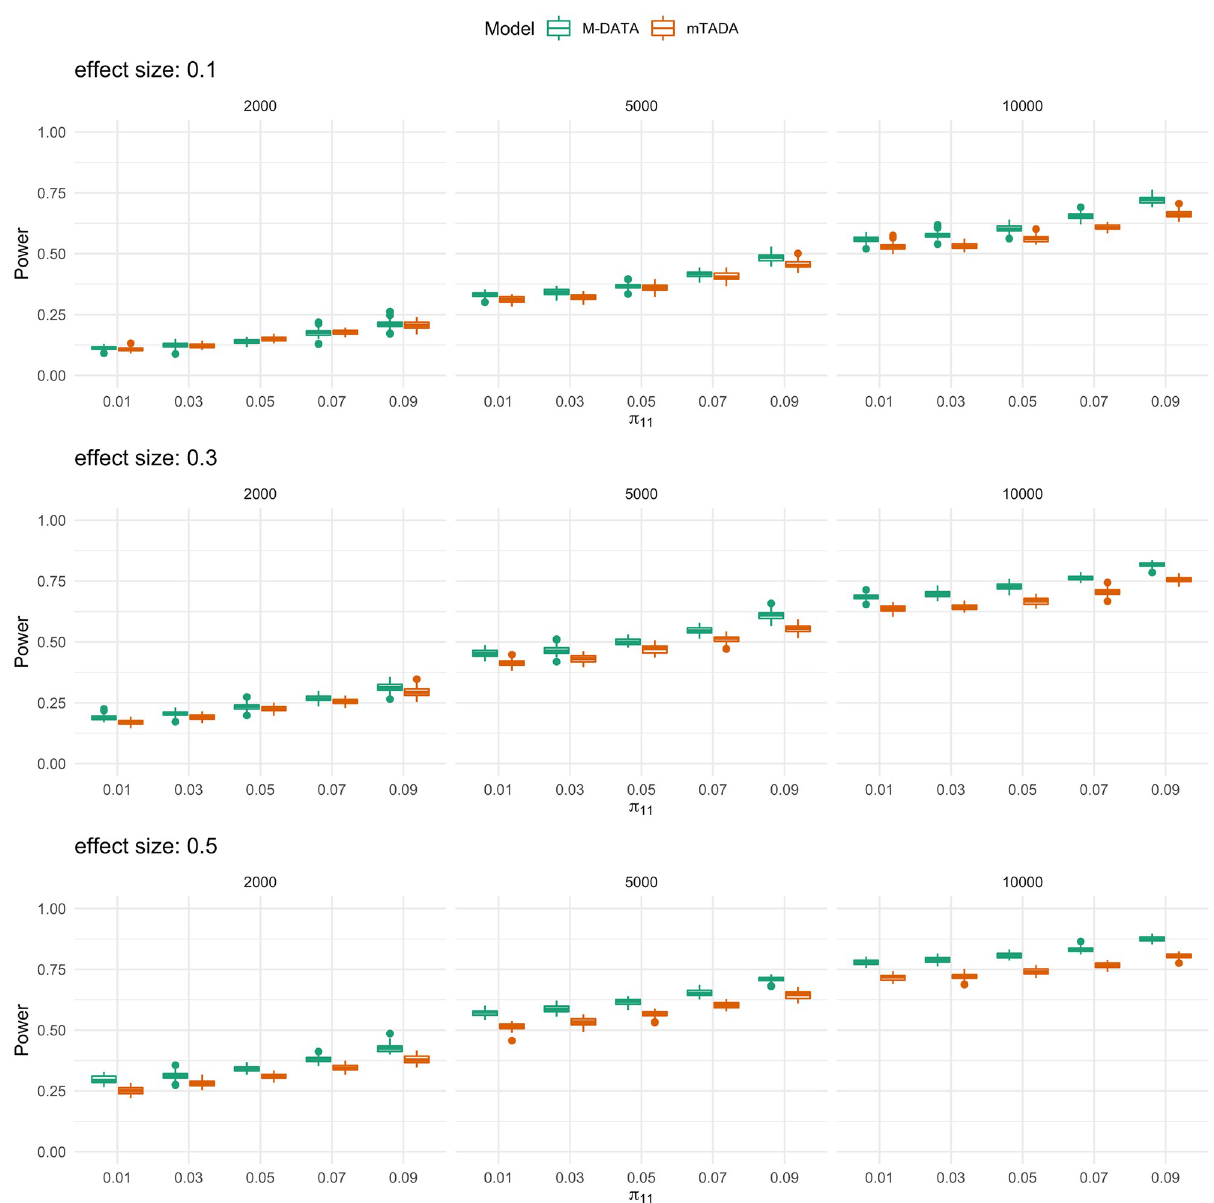
Fig 3. Comparisons of M-DATA and mTADA under different strengths of annotations. The panels from top to bottom show the power performance under weak, moderate and strong annotations, respectively. For each panel, each plot from left to right represents study sample size of 2000, 5000, and 10000, respectively. Within each plot, boxes from left to right represent the proportion of shared risk genes being 0.01, 0.03, 0.05, 0.07 and 0.09, respectively. Each scenario is replicated for 50 times in our simulations.